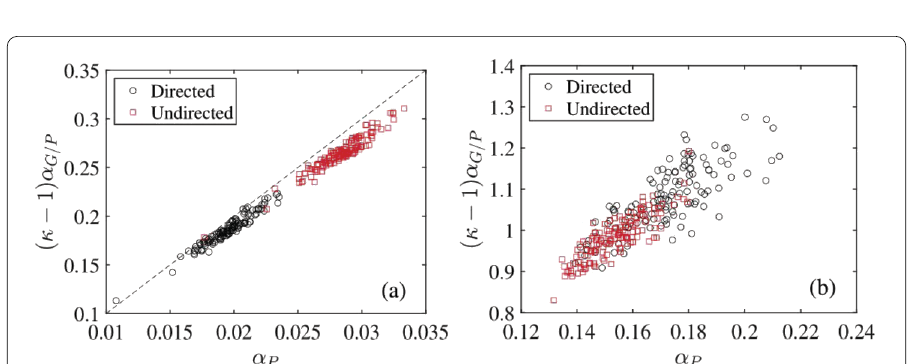
Figure 12 Testing the relationship ( κ – 1) α G / P = α P . The data for the dates during 1 February 2019 to 9 February 2019 are excluded. ( a ) Exponents α G / P are those in Fig. 9(a) for the directed networks and Fig. 9(c) for the undirected networks, while exponents α P are those in Fig. 6(a) for the directed networks and Fig. 6(c) for the undirected networks. ( b ) Exponents α G / P are those in Fig. 9(b) for the directed networks and Fig. 9(d) for the undirected networks, while exponents α P are those in Fig. 6(b) for the directed networks and Fig. 6(d) for the undirected